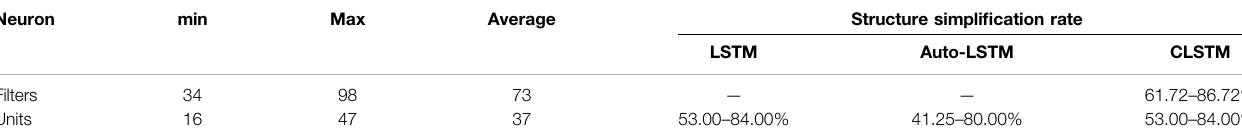
TABLE 7 | Network structure for 50 independent operations (Taiyangshan data